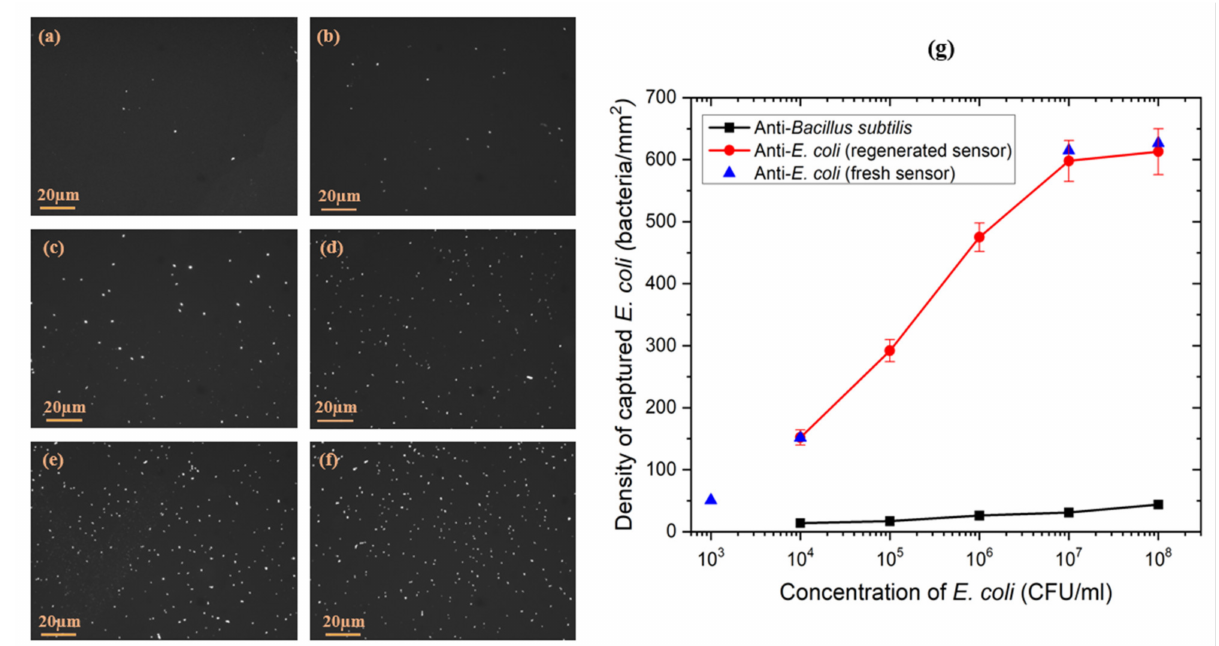
Figure 7. Examples of fluorescence images of GFP E. coli captured on the biofunctionalized GaAs surface of ZnO/GaAs biochips exposed to bacteria at ( a ) 10 3 CFU/mL, ( b ) 10 4 CFU/mL, ( c ) 10 5 CFU/mL, ( d ) 10 6 CFU/mL, ( e ) 10 7 CFU/mL, ( f ) 10 8 CFU/mL. Density of E. coli captured on the GaAs surface of the ZnO/GaAs biochip functionalized with antibodies against ( g ) B. subtilis (square symbols) or E. coli (circle and tringle symbols).